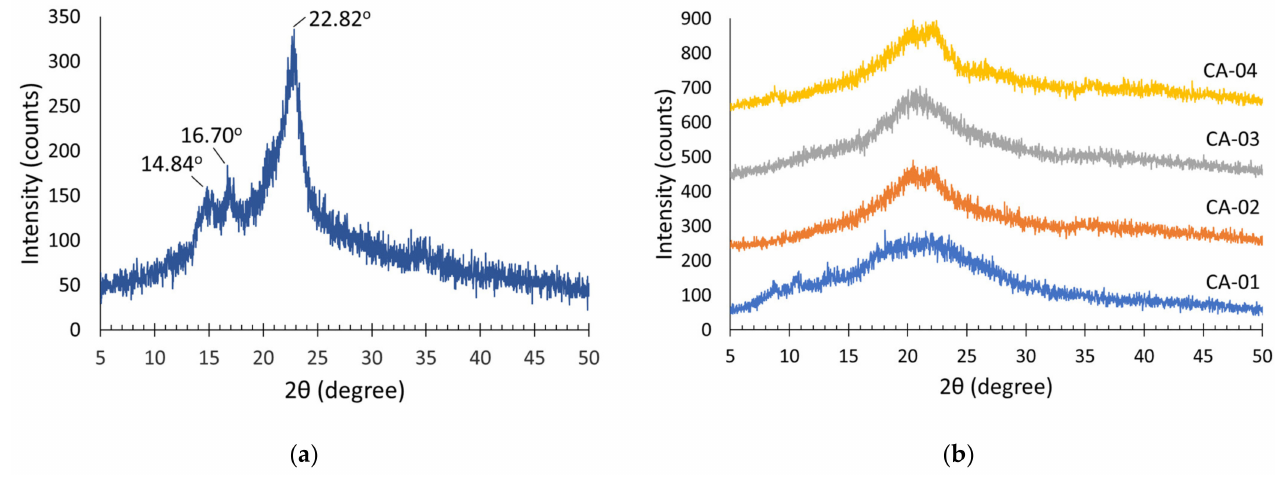
Figure 5. XRD patterns of ( a ) BC; ( b )